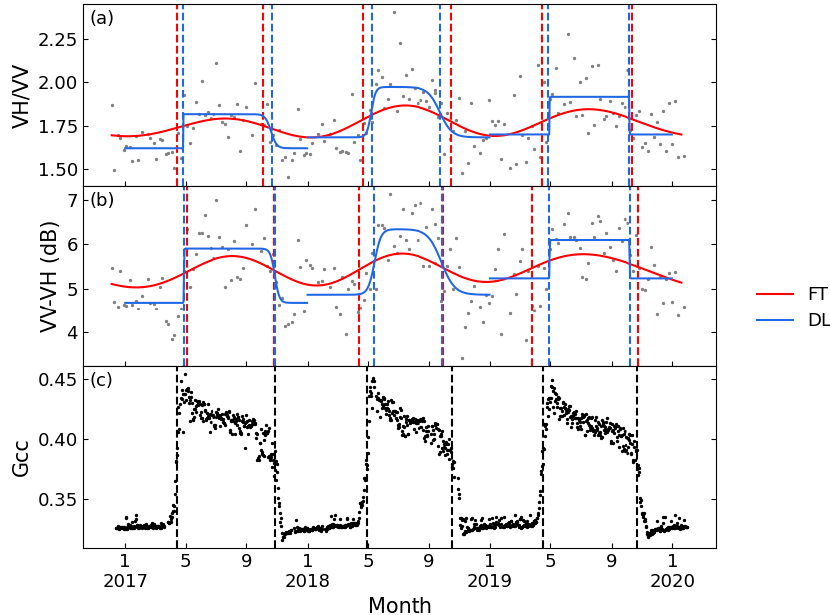
Figure 5. Seasonal patterns of Sentinel-1 for a typical deciduous forest (D02.SCBI) between 2017 and 2019. ( a ): VH/VV processed by FT and DL; ( b ): VV-VH processed by FT and DL; and ( c ): Gcc. Red lines: FT function; blue lines: DL function; and dashed line: phenological metrics.